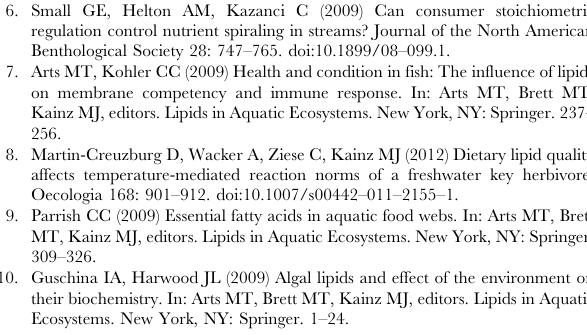
Table S1 Study sites and characteristics of 11 tributary systems of Lake Michigan. Table S2 Fatty acids measured in this analysis with reference materials. Table S3 Pearson correlation coefficients between